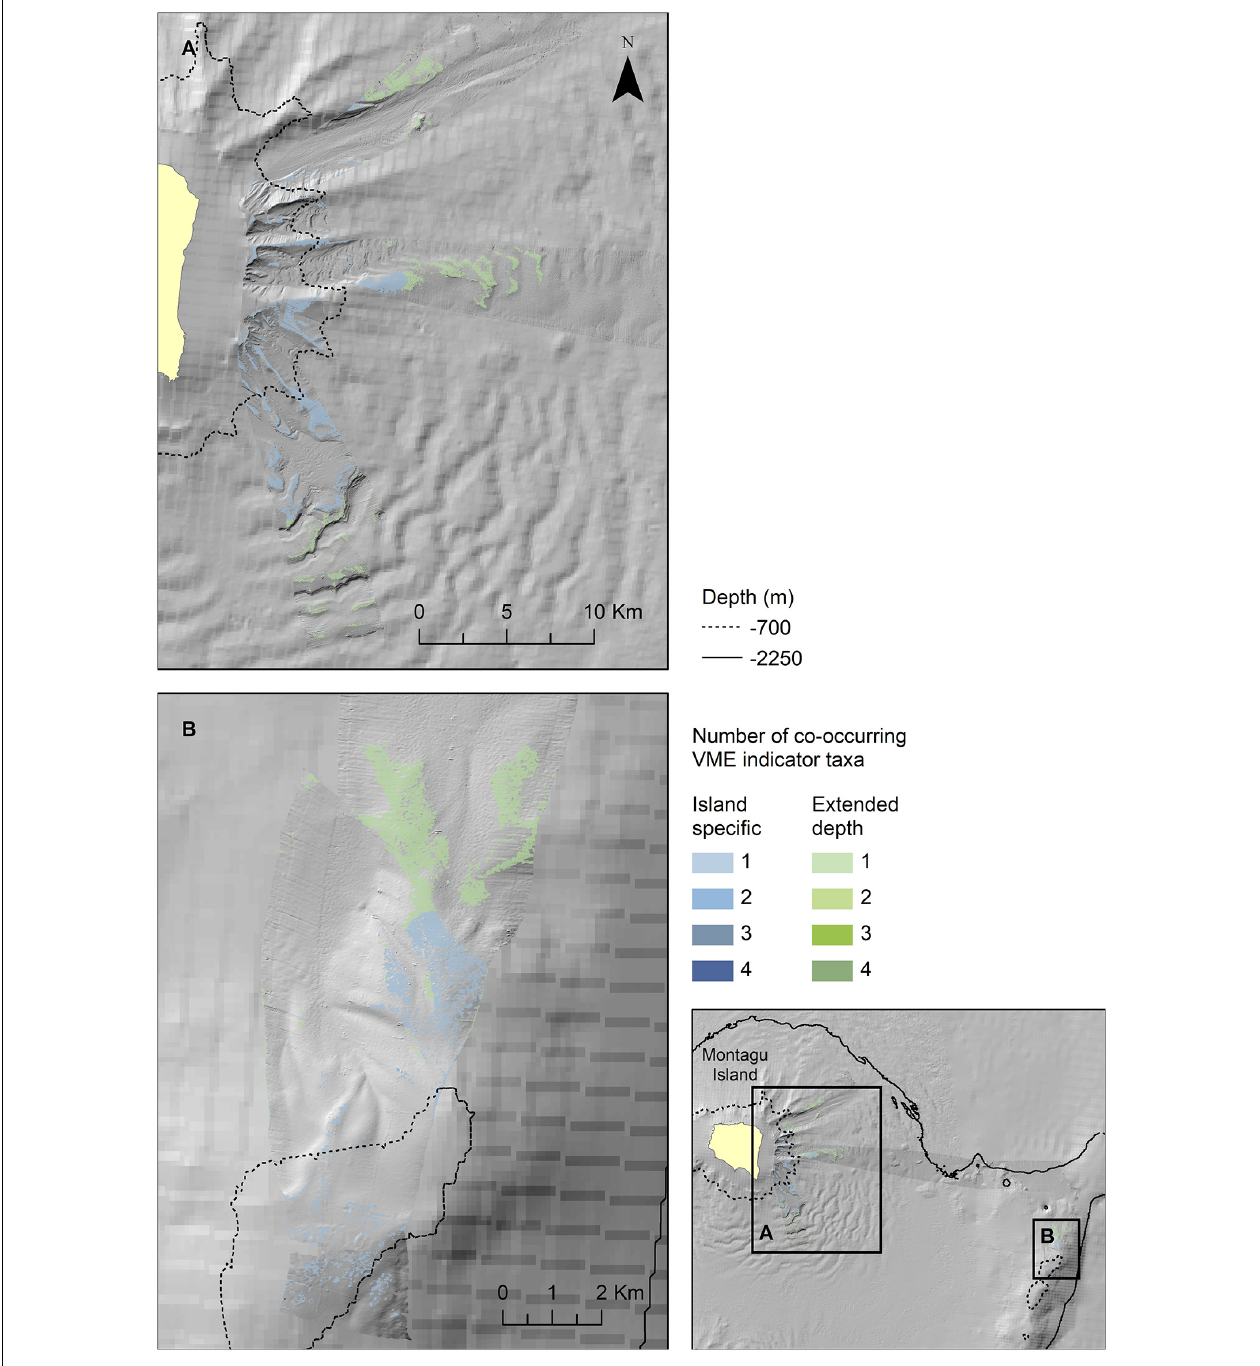
FIGURE 9 | Extrapolated extent of potentially suitable habitat for VME indicator taxa in the two survey locations at Montagu Island (A) and Bank (B) . Shown values refer to the number of VME indicator taxa for which suitable habitat is likely to co-occur. Blue colours indicate the extent within observed depth limit for this location, green colours indicate topographically suitable habitat present beyond the observed depth. High resolution bathymetry from DY99 is shown overlain on the South Sandwich Islands bathymetry compilation by Leat et al. (2014).